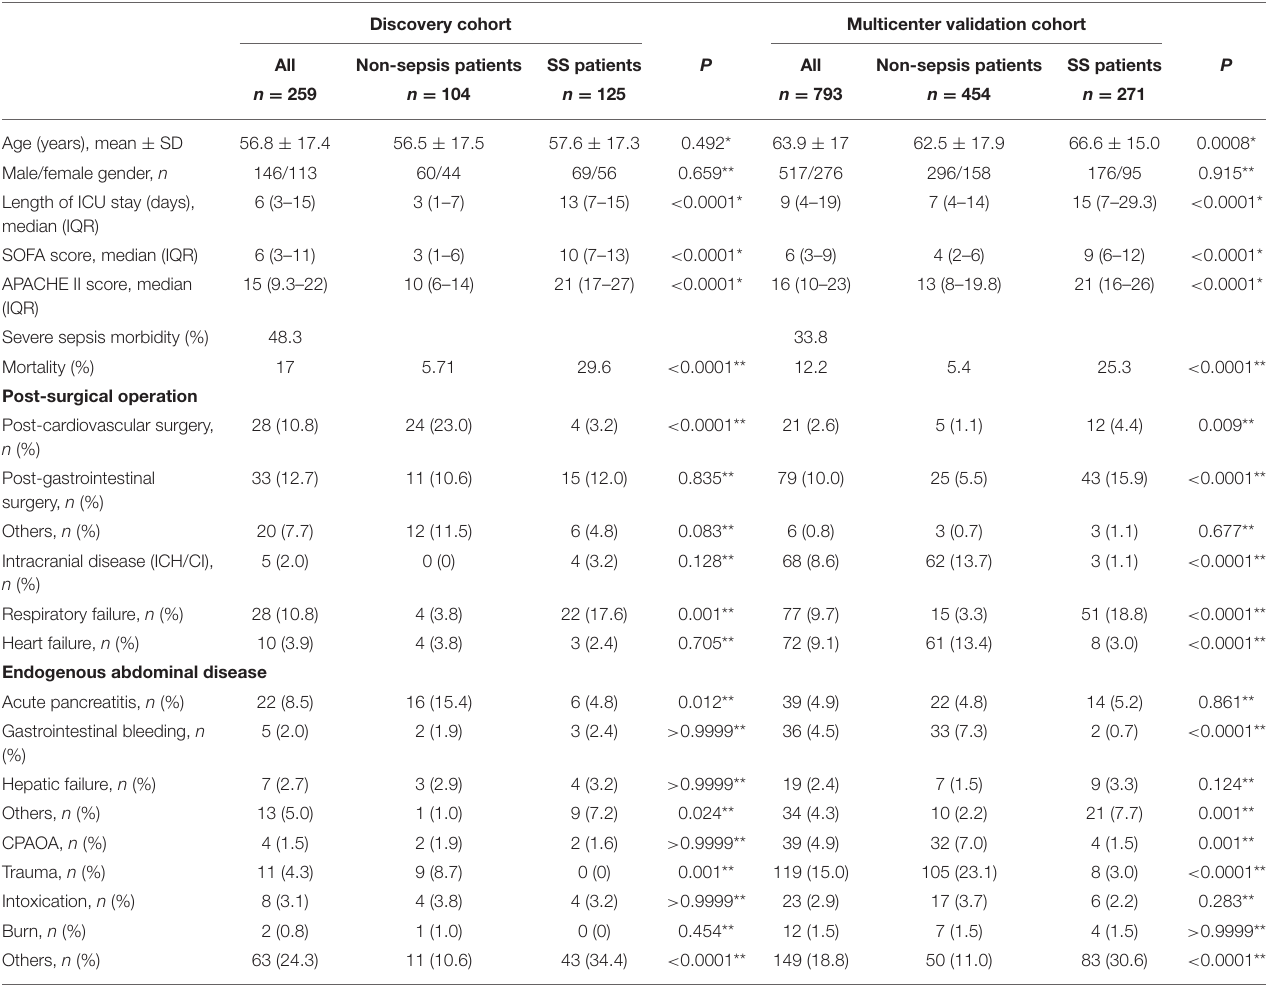
TABLE 1 | Baseline characteristics of the study population. Discovery cohort Multicenter validation cohort All Non-sepsis patients SS patients P All Non-sepsis patients SS patients